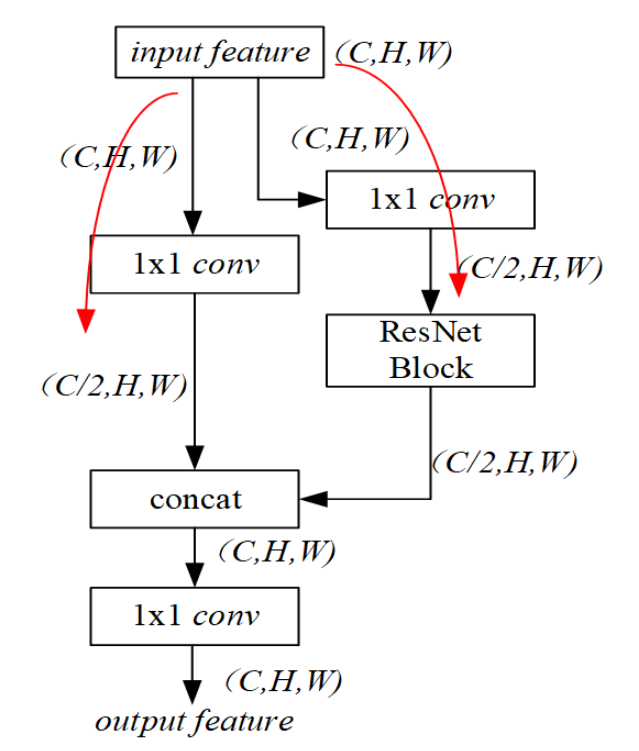
Figure 5. Cross-stage partial connection